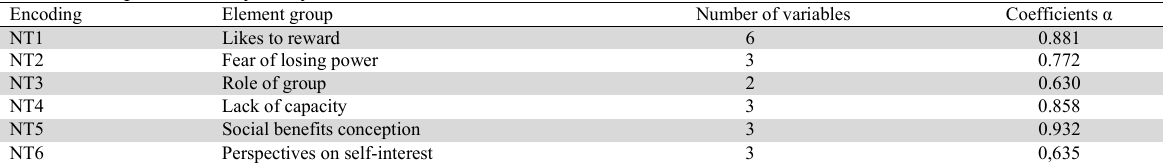
Cronbach's alpha reliability analysis Encoding